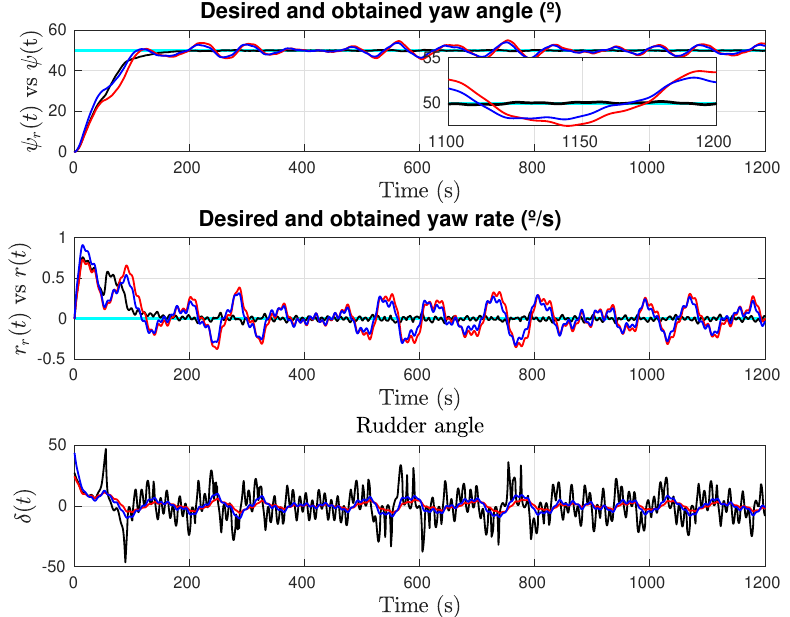
Figure 5. Constant yaw reference test with d ( t ) = 0. Adaptive parameters evolution.